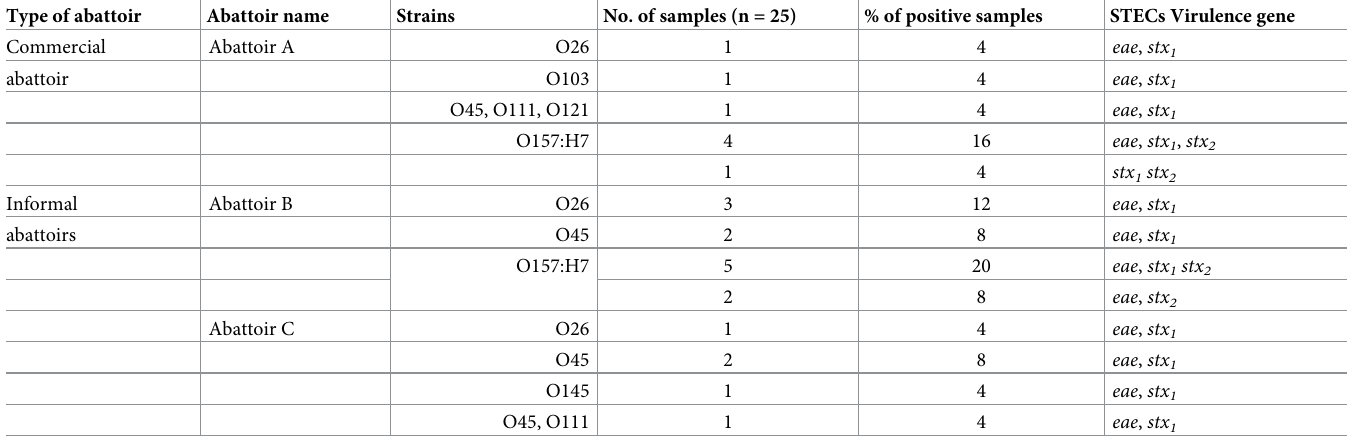
Table 4. Characterisation of STECs from meat sample bacterial isolates from both abattoirs. Type of